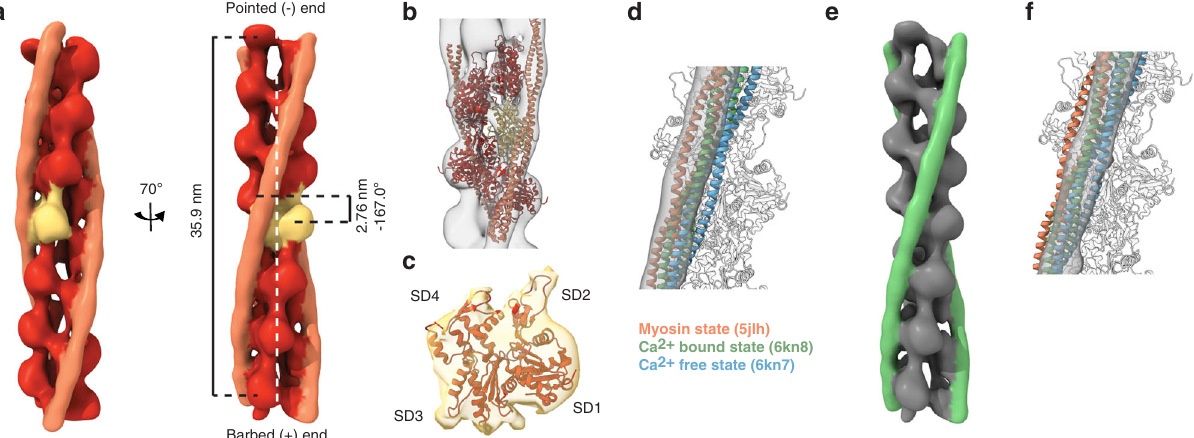
Fig. 5 In situ structure of the cardiac thin fi lament in two distinct functional states. a In situ subtomogram average of the cardiac actin fi lament (red and yellow) in complex with Tpm (orange) resolved at 15.7 Å (Supplementary Fig. 9c, orange curve, and Supplementary Movie 5). This structure was obtained from the wide-overlap data (Fig. 4b, c). The fi t of a pseudoatomic model of the F-actin-Tpm complex 10 into the subtomogram average ( b ) reveals F-actin polarity at the level of the actin monomers ( c ). d Docking of pseudoatomic models in different states 10,19 into the map reveals that the thin fi lament is in the myosin state (see also Supplementary Fig. 9d). e In situ subtomogram average of the cardiac actin fi lament (gray) in complex with Tpm (green) resolved at 17.7 Å (Supplementary Fig. 9c, green curve). This structure was obtained from the narrow-overlap data (Fig. 4d). f The Ca 2 + bound state fi tted best to the subtomogram average in e (see also supplementary Fig. 9e), indicating that this sarcomere is in a different state of the contraction